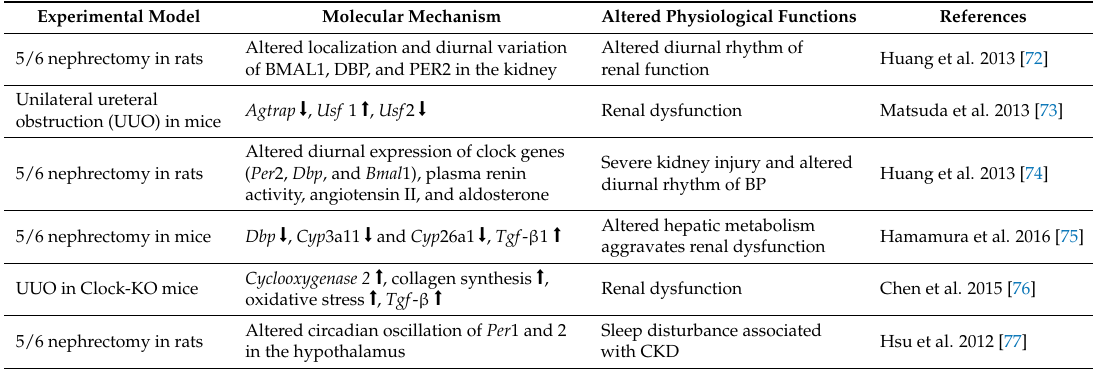
Table 2. Altered expression profiles of the molecular components of the circadian timing system in subjects with CKD that are directly or indirectly associated with a disrupted dipping pattern of BP. ( ⬇ ) denotes reduced expression of indicated gene; (⬆) denotes increased expression of indicated gene.